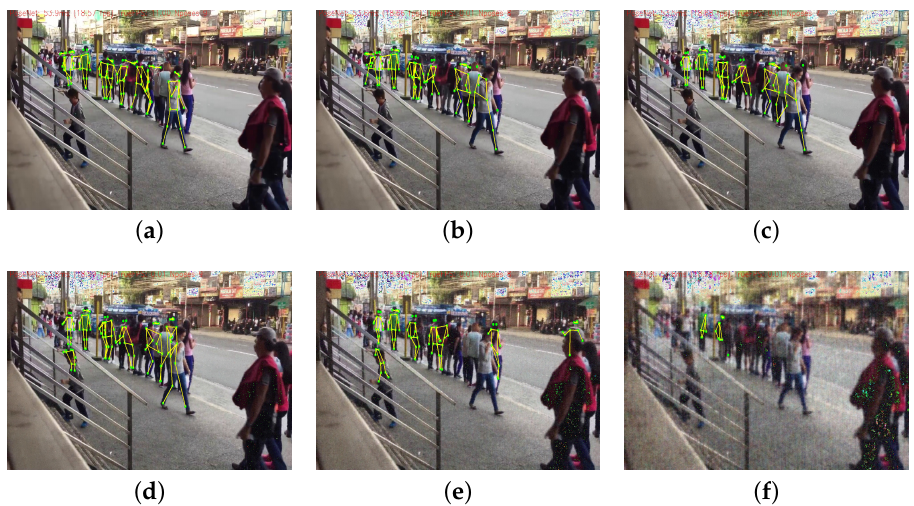
Figure 3. Outputs of the PoseNet model for video resolution of 1280 × 720: ( a ) original image, ( b ) CS rate of 90%, ( c ) CS rate of 70%, ( d ) CS rate of 50%, ( e ) CS rate of 30% and ( f ) CS rate of 10%.